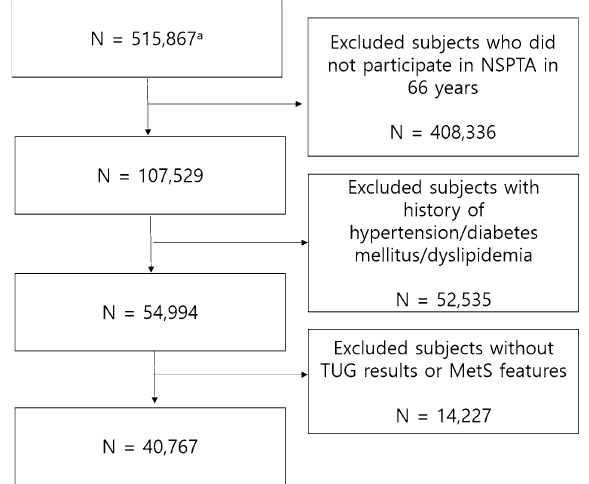
Figure 4. Flow of subject selection. a Number of subjects in the National Health Insurance Service–National Health Screening Cohort database of the Korean National Health Insurance Service (2002–2015). * MetS metabolic syndrome, TUG timed up and